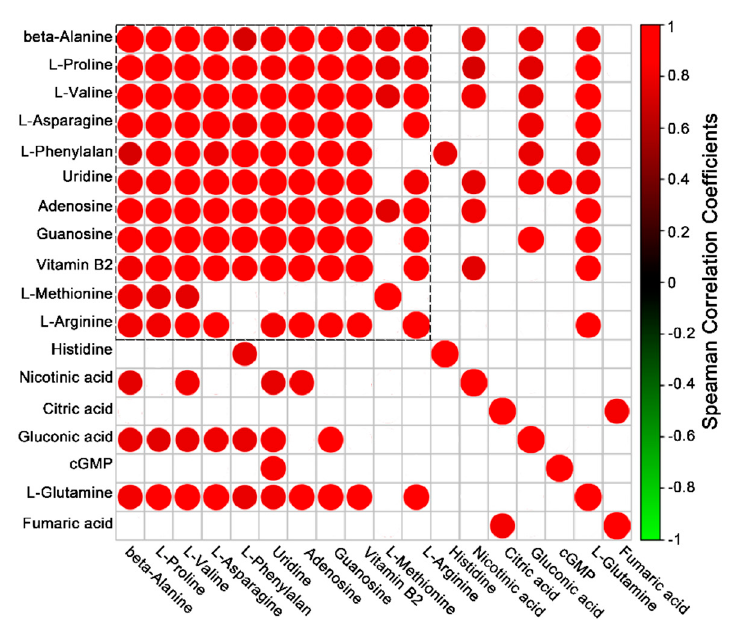
Figure 4. Correlation matrix and cluster analysis of the results obtained from data on 18 metabolites for WT (red), 1124 (green), and 112458 (blue) plants. Each square indicates the Pearson’s correlation coefficient for a pair of compounds, and the value for the correlation coefficient is represented by the intensity of the blue or red color as indicated on the color scale. Hierarchical clusters are represented by a cluster tree.